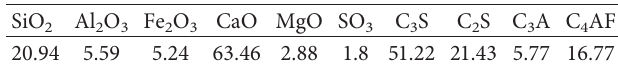
Table 3: Cement components (%).